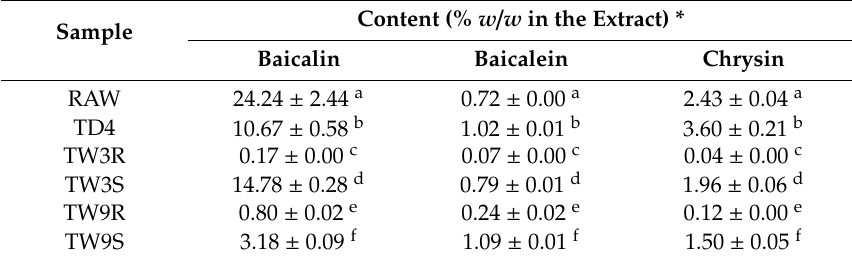
Table 1. Flavonoid contents in O. indicum extracts determined by high-performance liquid chromatographic (HPLC).